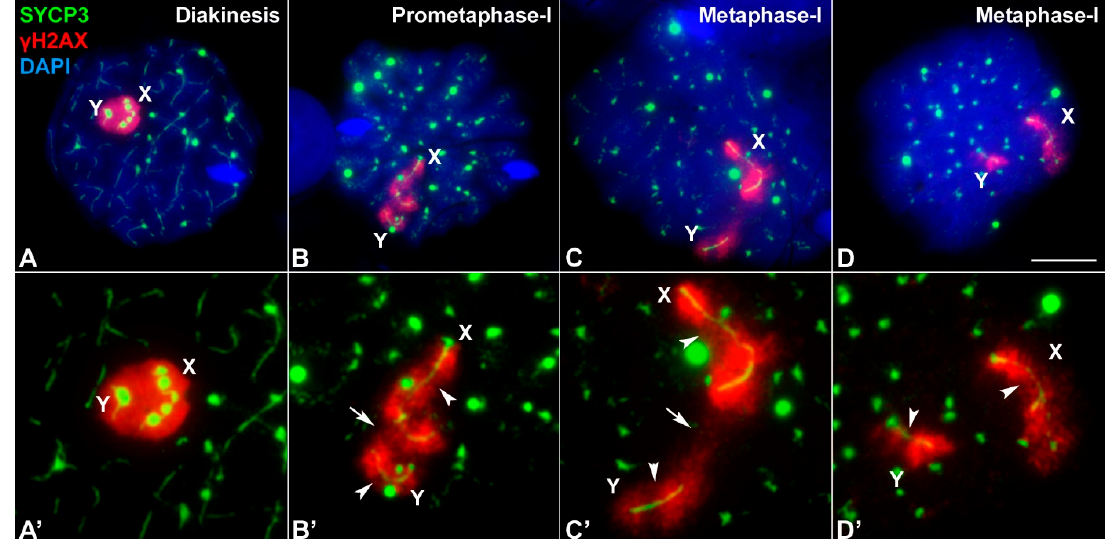
Figure 6. Association of sex chromosomes during late stages of first meiotic division. Spread spermatocytes labelled with antibodies against SYCP3 (green) and γ H2AX (red) and counterstained with DAPI (blue). ( A ′ – D ′ ) shows enlarged images of the sex chromosomes presented in ( A – D ). ( A – A ′ ) Diakinesis: SYCP3 appears as thin lines along each bivalent. Some protein aggregates are observed, particularly in the sex chromosomes. γ H2AX signal covers the sex chromosomes, which are closely associated. ( B – B ′ ) Prometaphase-I. SYCP3 is observed as a discontinuous line inside each bivalent, and abundant SYCP3 aggregates decorate the nucleus. SYCP3 is also observed running inside the X and Y chromosome. The X chromosome shows a conspicuous bending, adopting a hook-like shape. The γ H2AX signal in the sex chromosomes becomes discernible for each chromosome, although both chromosomes are still closely associated (arrow). Some regions along sex chromosomes have a weaker labelling with γ H2AX (arrowheads). ( C ) Metaphase-I. SYCP3 signal becomes weaker inside the autosomes and preferentially accumulates in the centromeric regions. Sex chromosomes are clearly more separated than in previous stages, but there is a γ H2AX bridge connecting them (arrow). The X chromosome still has a hook-like configuration. ( D ) Metaphase-I. SYCP3 signal is barely detectable inside the autosomes and mostly accumulates in the centromeric regions. Sex chromosomes have apparently lost their contact. γ H2AX weaker regions are still differentiated in the sex chromosomes (arrowheads). Scale bar: 10 µm.